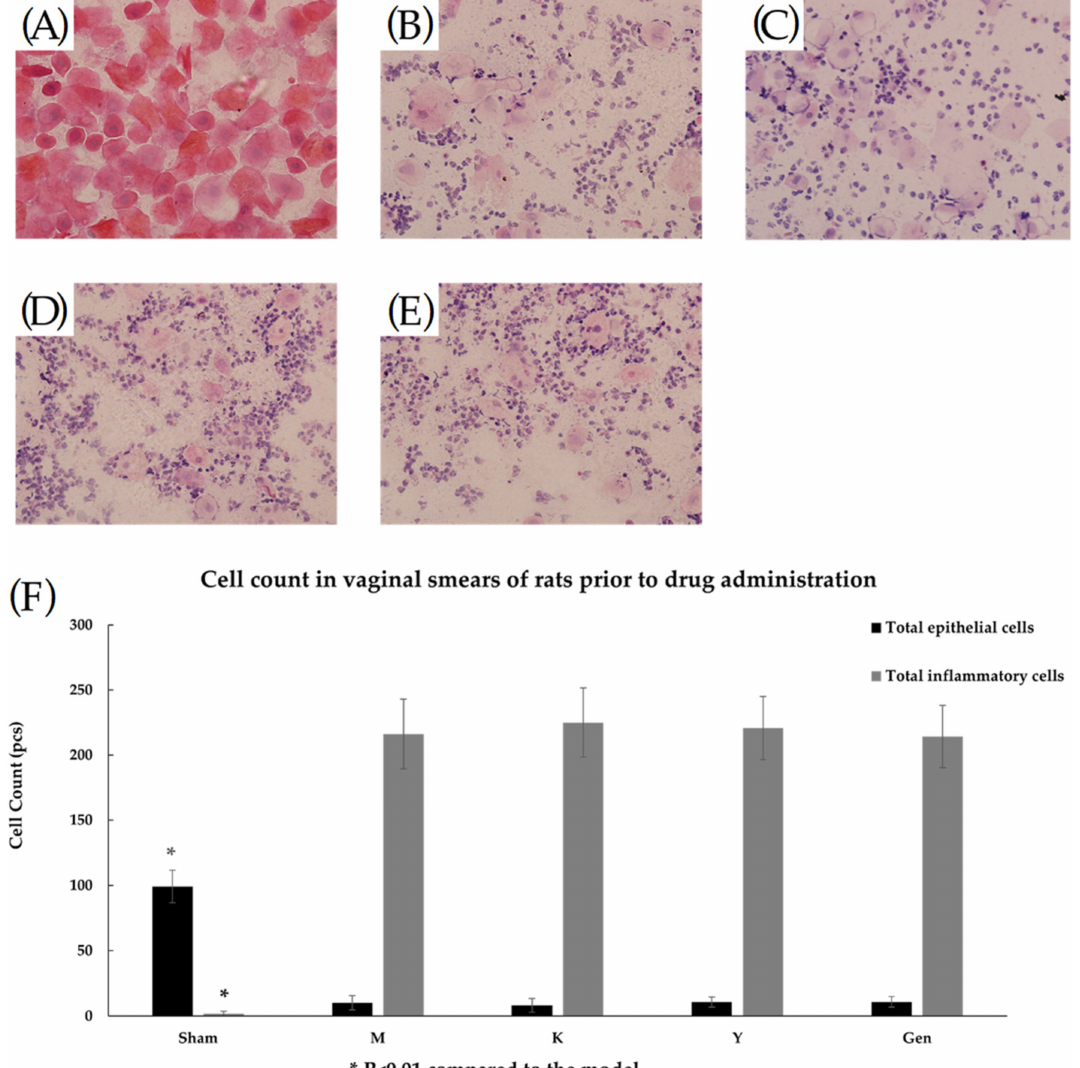
Figure 3. ( A ) After HE staining treatment, a vaginal smear from the Sham group of rats before administration of the drug showed a large number of epithelial cells and a very small number of inflammatory cells, (40X). ( B ) After HE staining treatment, vaginal smears from rats in group M before dosing were heavily infiltrated with inflammatory cells and a few epithelial cells, (40X). ( C ) After HE staining treatment, vaginal smears from rats in group K before dosing were heavily infiltrated with inflammatory cells and a few epithelial cells, (40X). ( D ) Vaginal smears from rats in group Y after treatment with HE stain, (40X). ( E ) Vaginal smears from rats in group Gen after treatment with HE stain, (40X). ( F ) Results of separate counts of epithelial cells and inflammatory cells in vaginal smears of rats before administration. * p < 0.01 compared to the model